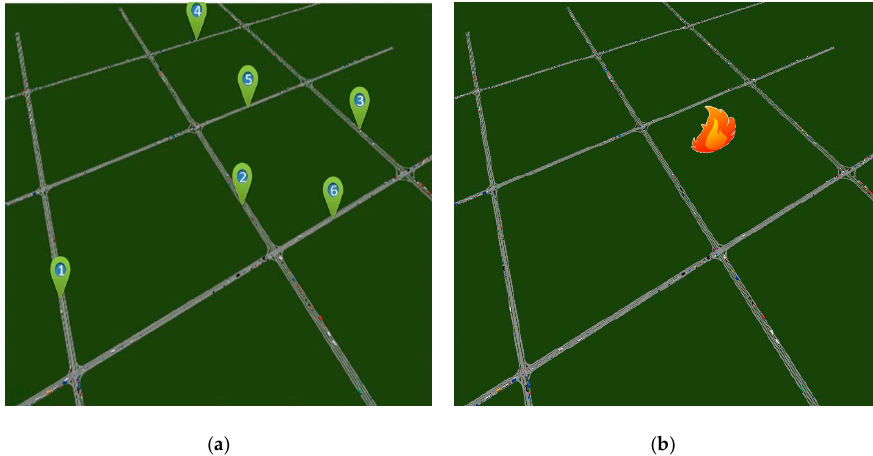
Figure 3. Snapshot of Sudoku tra ffi c network in simulator. ( a ) Scenario without sudden fire disasters. ( b ) Scenario with sudden fire disasters.